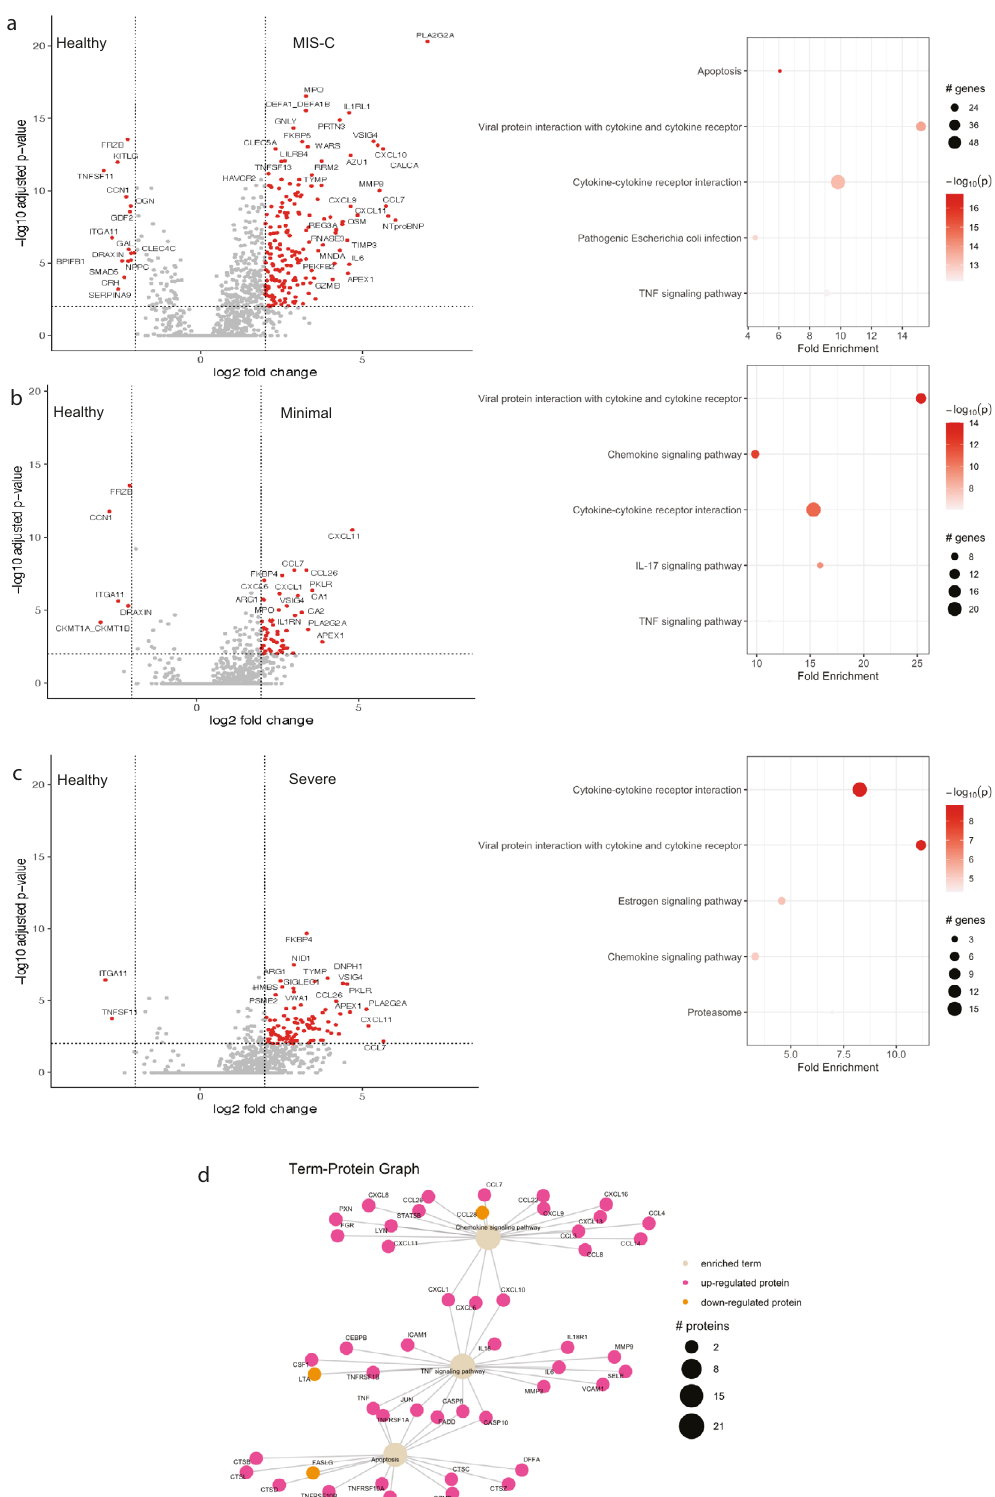
Fig. 2 Differentially expressed proteins and ranked pathway analysis for each disease state compared to healthy controls. Differentially expressed proteins (DEPs), log2 fold change threshold of 2 and FDR threshold of 0.01, between patients with MIS-C ( N = 22) and healthy controls ( N = 25) are shown in a , along with ranked pathway analysis. Size of dots represents number of enriched genes and intensity of colors represents p -value associated with enrichment analysis. DEPs and ranked pathway analysis are shown for patients with minimal Severe Acute Respiratory Syndrome Corona Virus 2 (SARS-CoV-2; N = 26) infection compared healthy controls ( N = 25) ( b ), and Severe Coronavirus Disease (COVID-19; N = 15) patients compared to healthy controls ( N = 25) ( c ). Network analyses for ranked pathway analysis between patients with MIS-C ( N = 22) and healthy controls are shown in d where up-regulated proteins are colored in green and down-regulated proteins are colored in red. Node size of the pathway term represents number of input proteins implicated in the pathway. Source data are provided as a Source Data fi